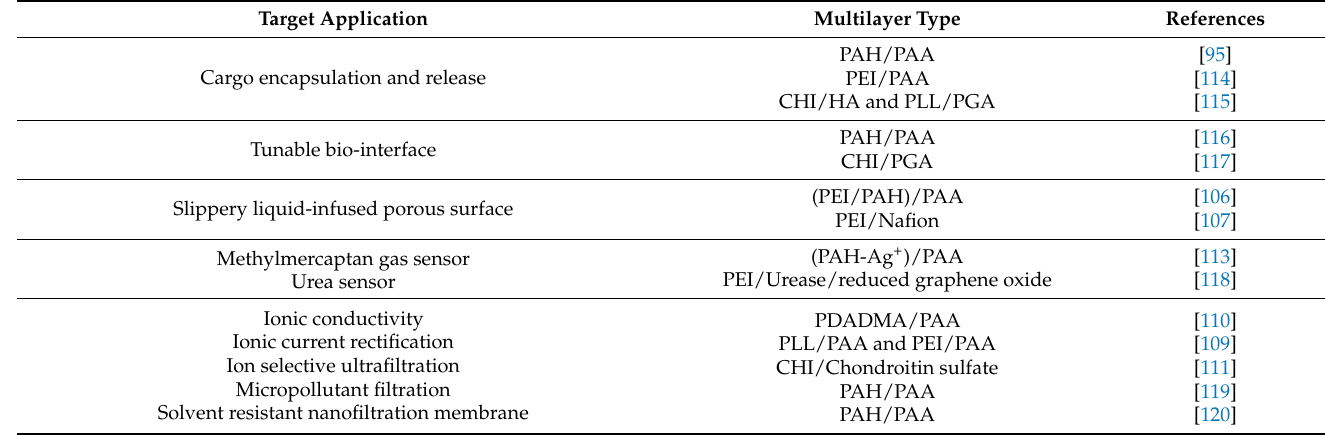
Table 4. Typical LbL multilayer films based on weak polyelectrolytes and emerging